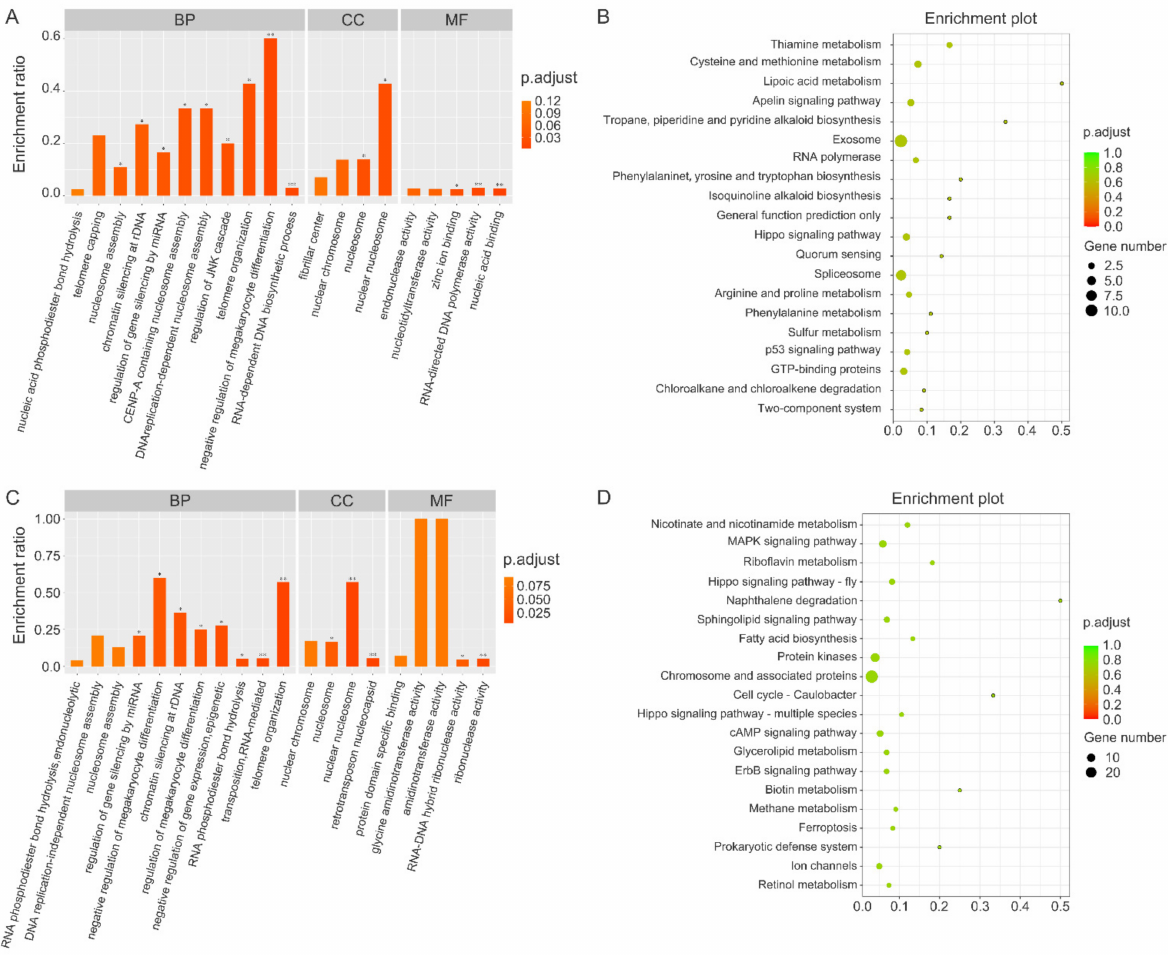
Figure 4. GO and KEGG analysis of genes differentially bound to MITF in purple and white sea cucumber, compared with those in green sea cucumber. ( A ) Gene Ontology classification in purple A. japonicus . ( B ) KEGG pathway analysis in purple A. japonicus . ( C ) Gene Ontology classification in white A. japonicus . ( D ) KEGG pathway analysis in white A. japonicus . “*” indicates significant differences with p < 0.05; “**” indicates significant differences with p <